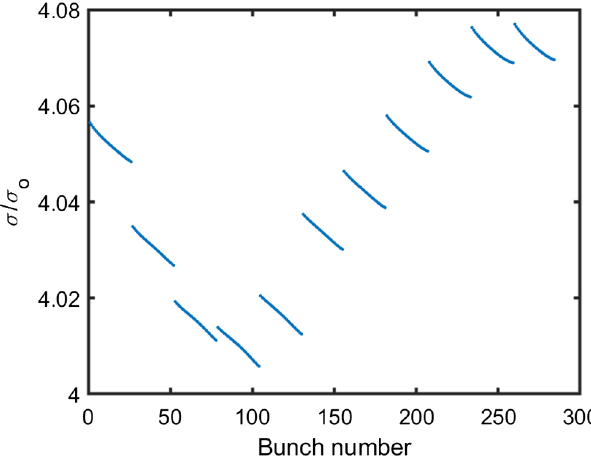
FIG. 8. Ratio of bunch length to natural bunch length vs bunch number, with distributed